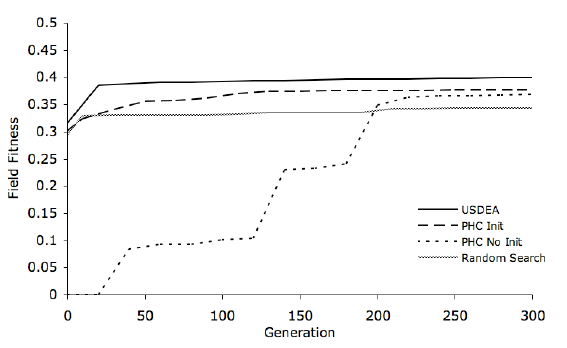
Fig.7. Benchmarking for a Cluster Field with an MNC of 2 In the case of cluster fields with an MNC of 2, shown in Fig. 7, the “PHC No Init” takes approximately 200 generations to achieve fitness similar to “PHC Init”.